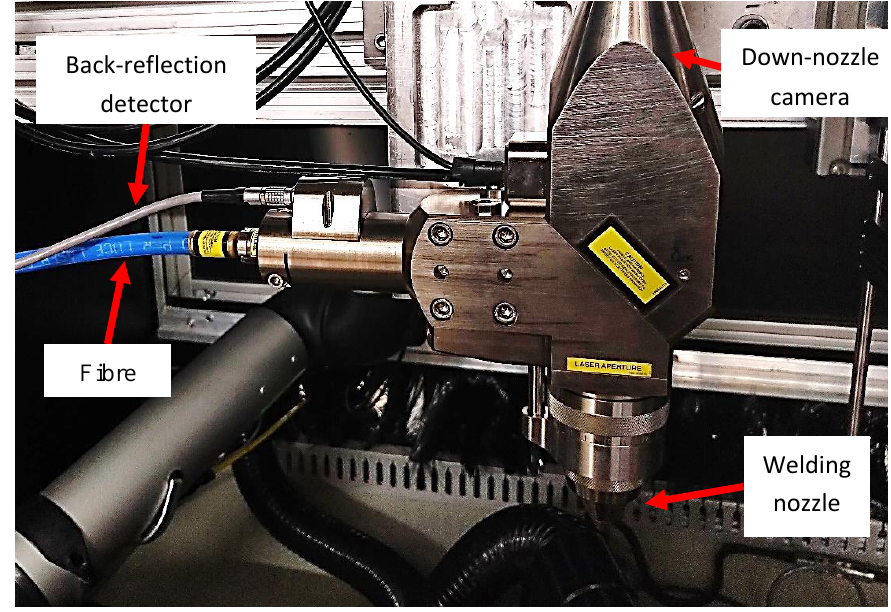
Figure 1. Laser welding head.